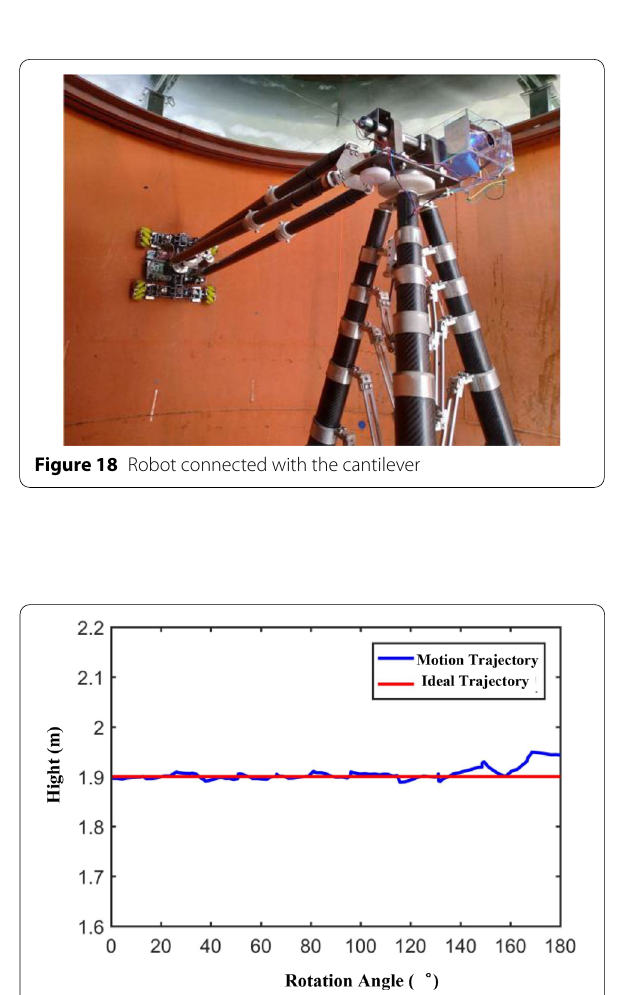
Figure 19 Trajectory of the robot measured by the support